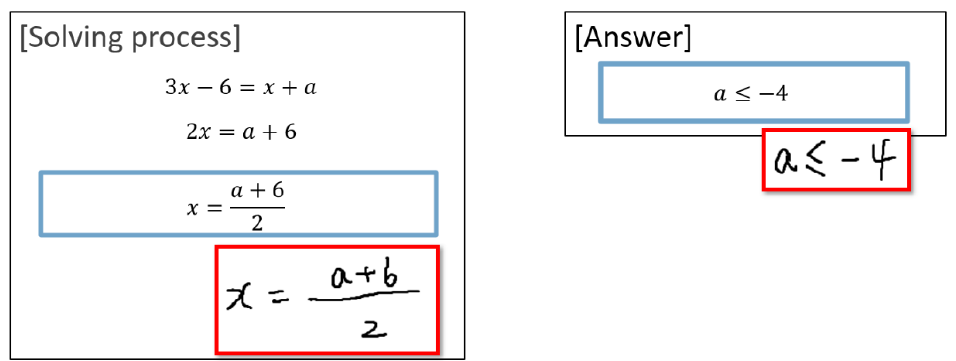
Figure 4 . Input position of expression. Figure 4. Input position of